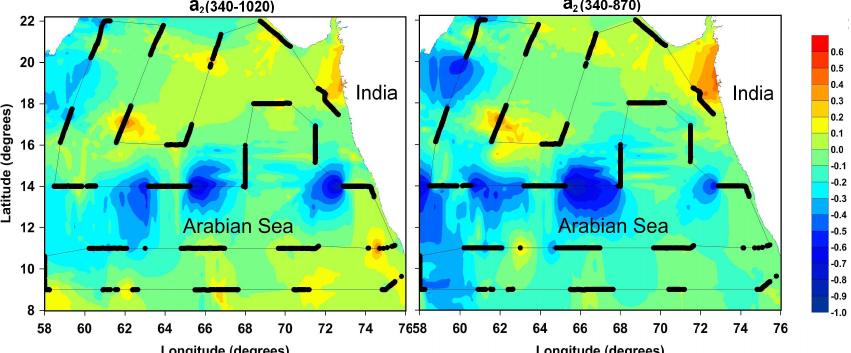
Fig. 10. Same as Fig. 9, but for the a 2